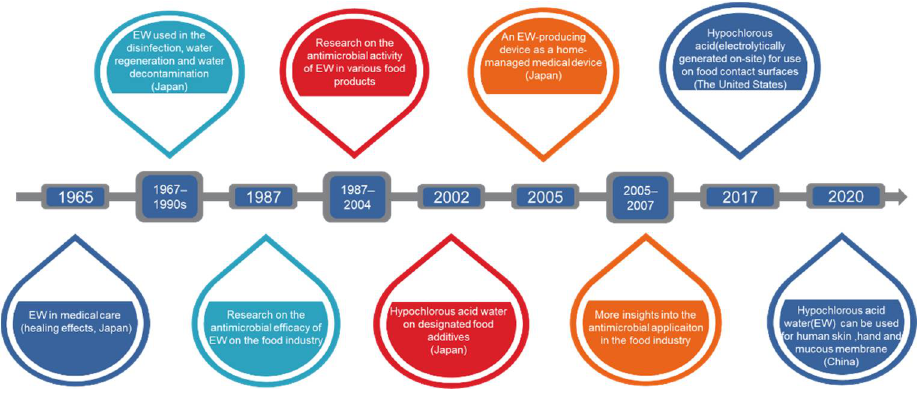
Figure 1. History of electrolyzed water